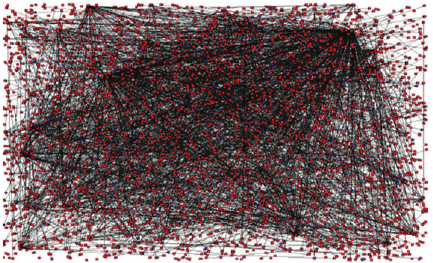
Figure 3: Original network of information